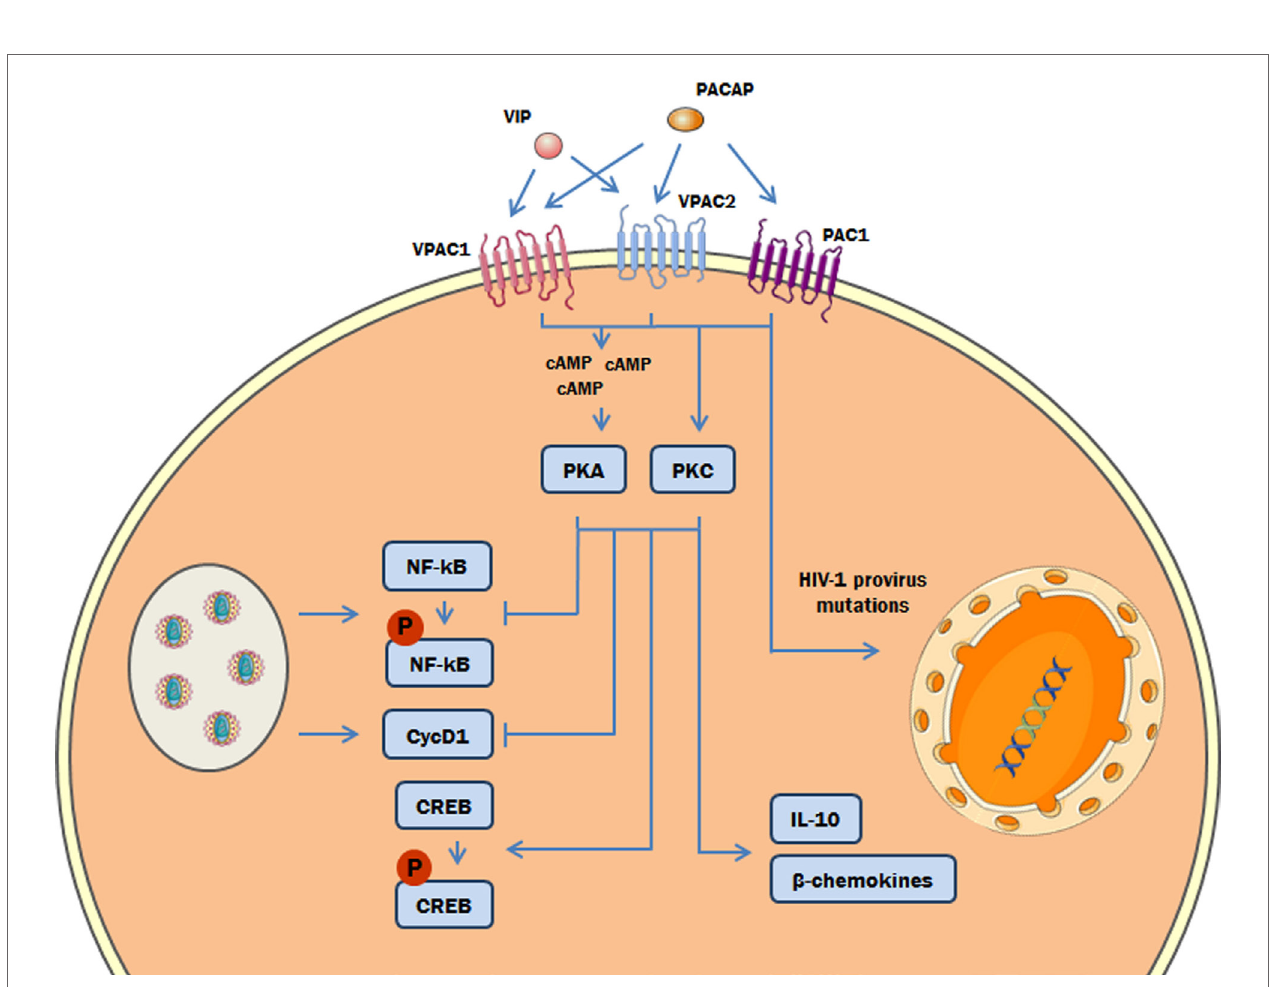
FigUre 9 | Proposed model of the role of protein kinases A (PKA) and C (PKC) in the vasoactive intestinal peptide (VIP)/pituitary adenylate cyclase-activating polypeptide (PACAP)-mediated inhibition of HIV-1 replication in macrophages. The interaction of VIP and PACAP with their specific receptors in HIV-1-infected macrophages activates PKA ( via induction of cAMP) and PKC, leading to inhibition of NF-kB activation and Cyclin D1 synthesis induced by HIV-1 infection, and to reduction of HIV-1 production. Also, PKA and PKC activation can trigger the phosphorylation of cAMP response element-binding protein (CREB) and the macrophage production of β -chemokines and IL-10, which diminish HIV-1 replication (27). In addition, PACAP introduces mutations on HIV-1 provirus that result in a reduction of HIV-1 replication fitness (the color green in the DNA represents the integrated HIV-1